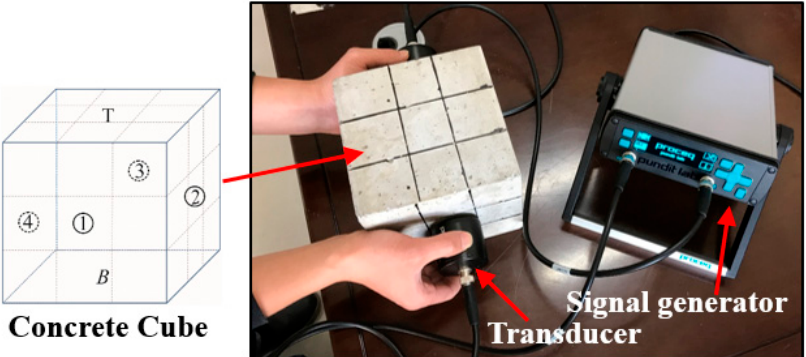
Figure 2. The setup of the ultrasonic speed test. The different surfaces of concrete are denoted as ① , ② , ③ , ④ , T, and B. T and B represent the top and bottom surfaces. Each surface of the concrete was marked into 3 × 3 partitions and then measured with the ultrasonic test equipment.